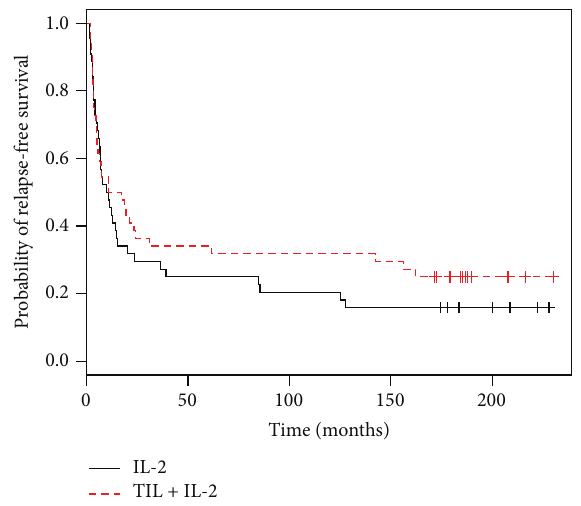
Figure 1: Relapse-free survival in the TIL + IL-2 group: this difference was not significant ( 𝑃 = 0.45 ; log-rank test); 16.7 years of median followup.